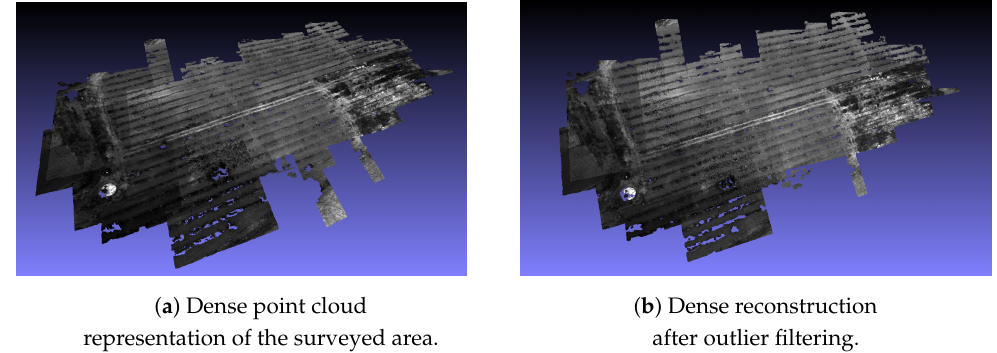
Figure 14. Dense reconstruction resulted from the MVS algorithm. Figure 14b represents the model after point filtering was